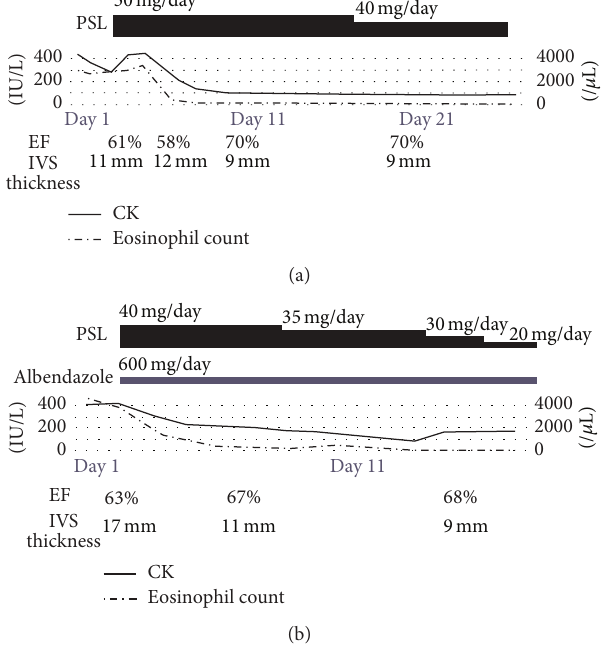
especially due to an increase in the eosinophil count (2,880/ 𝜇 L) and elevated enzymes: creatinine phosphokinase (CK) of 303 IU/L and Troponin-I of 1.863 ng/mL. Electrocardiogram